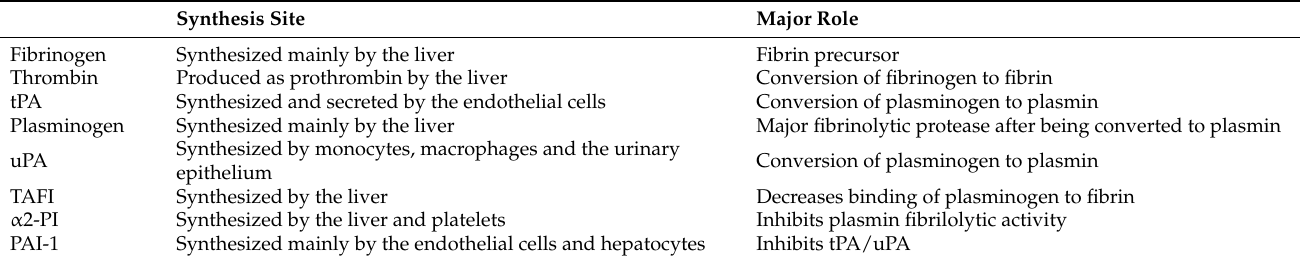
Table 1. Principal components of the coagulation and fibrinolytic